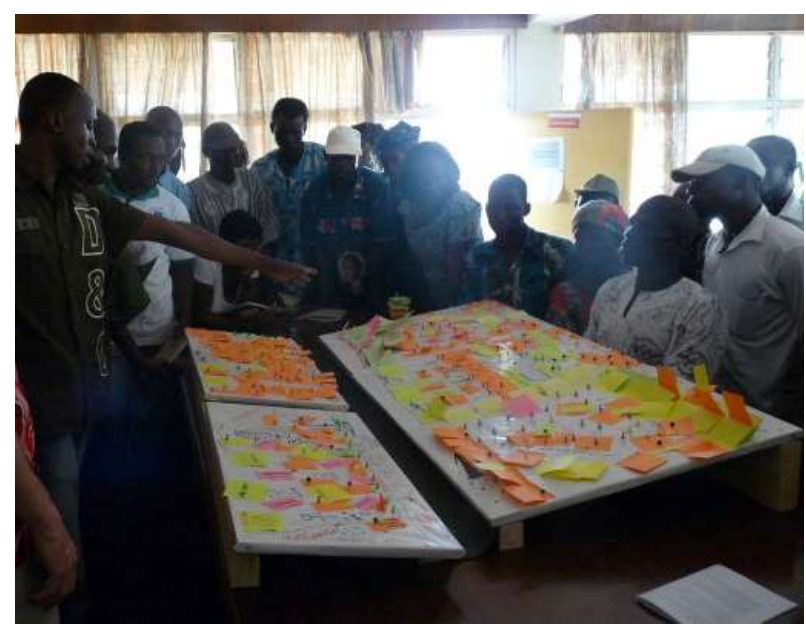
Figure 3. Material used in participatory workshop 1 (PW1): nested inclined white wooden panels (representing different portions of a watershed) and colored post-its and pins representing different land-use types.